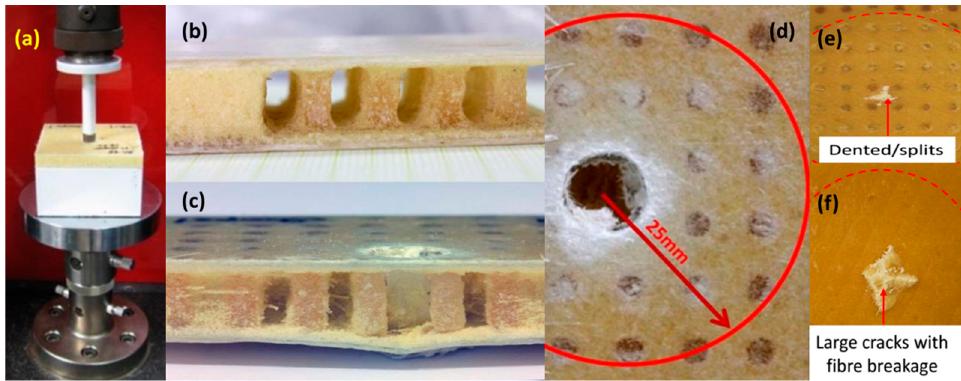
Figure 4. ( a ) Indentation test of foam core composite sandwich panel, ( b ) PFCS panel (foam partially removed to show pins), and the failure modes of PFCS panels ( c ) side view, and ( d ) top view ( e ) failure of back face for PFCS and ( f ) failure of back face sheet of FCS [31].